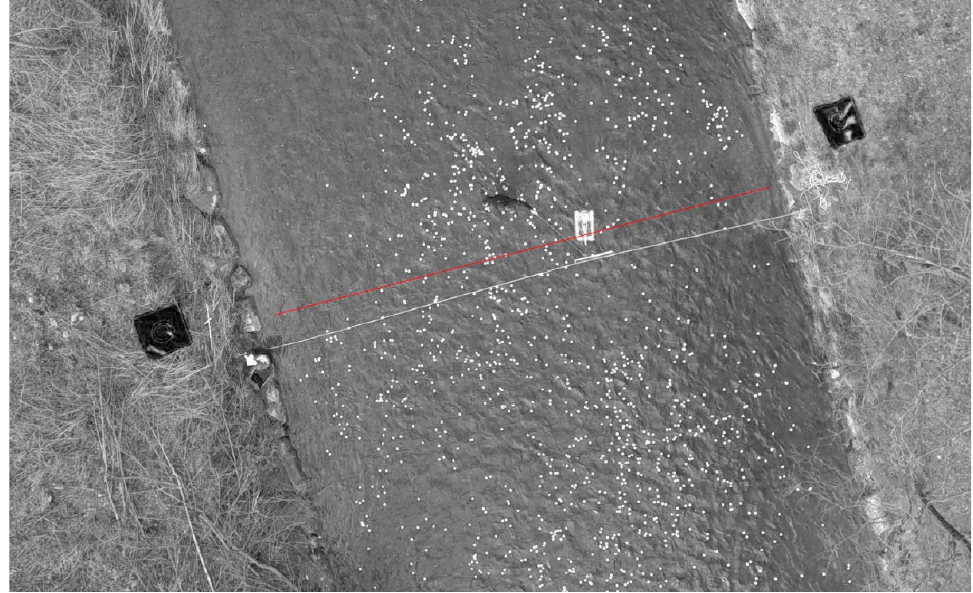
Figure 4. A part of a frame from Murg River video; the surface velocities are estimated along the displayed red